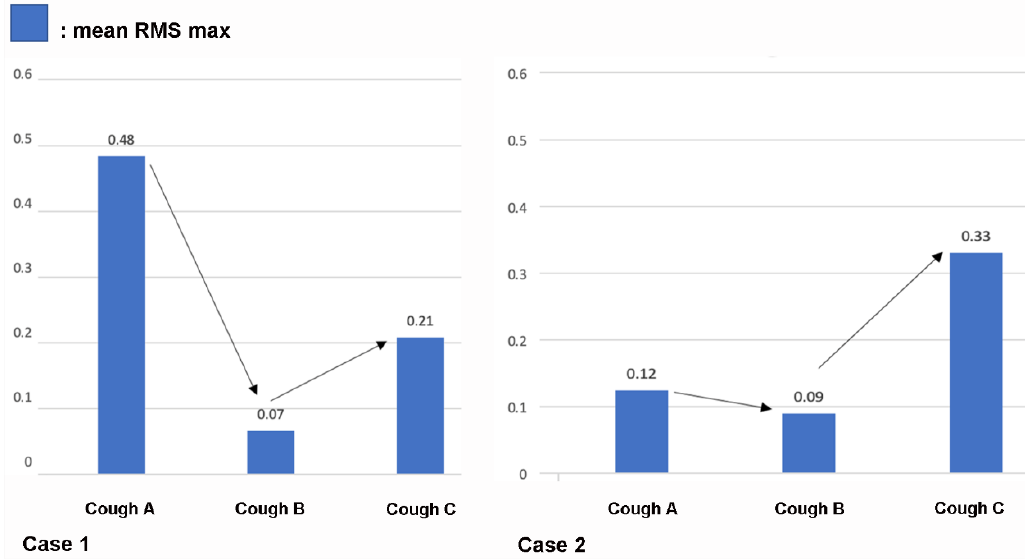
Figure 6. Root mean square (RMS) values presented as a time graph. Maximum RMS values were significantly reduced when the cases were diagnosed with aspiration pneumonia and were higher when the patients’ status improved, and they were able to resume oral feeding.